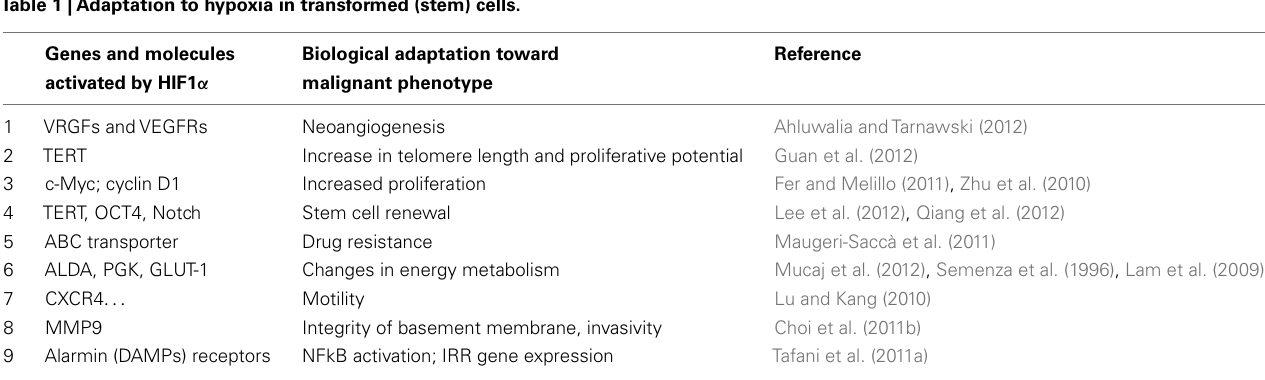
Table 1 |Adaptation to hypoxia in transformed (stem)